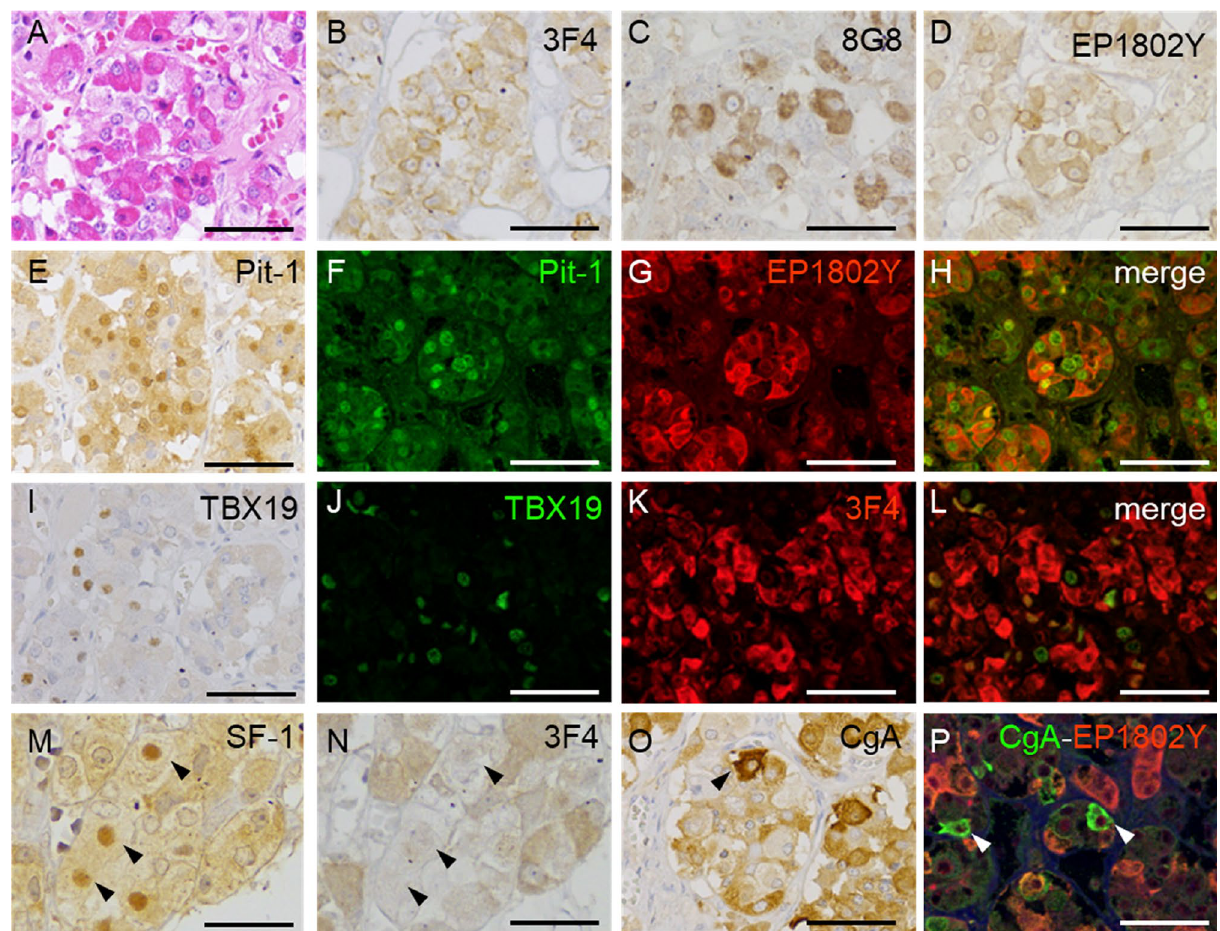
Figure 5. Cellular distribution of prion proteins (PrP) in the pituitary gland. ( A ) Hematoxylin and eosin staining show normal adenohypophyseal cell appearance (case 6). ( B – D ) Immunohistochemistry for PrP antibodies shows cytoplasmic PrP in adenohypophyseal cells (case 6; B : 3F4, C : 8G8, D : EP1802Y). ( E ) Immunohistochemistry for positive transcription factor 1 (Pit-1) reveals nuclear Pit-1. ( F – H ) Double immunofluorescence of Pit-1 and PrP (EP1802Y) shows that most cytoplasmic PrP-positive adenohypophyseal cells are immunopositive for nuclear Pit-1. ( I ) Immunohistochemistry for T-Box transcription factor 19 (TBX19) shows some adenohypophyseal cells with positive nuclei. ( J – L ) Most cytoplasmic PrP-positive cells are negative for nuclear TBX19. ( M , N ) On mirror images of immunohistochemistry for steroidogenic factor 1 (SF-1) ( M ) and PrP ( N ), most of the cytoplasmic PrP cells were negative for nuclear SF-1 (asterisks). ( O ) Most adenohypophyseal cells were positive for cytoplasmic chromogranin A (CgA), and several had strong expression (arrowhead). ( P ) Double immunofluorescence for CgA and PrP (EP1802Y) indicated colocalization in most cells, but cytoplasmic PrP was negative in cells strongly expressing CgA.